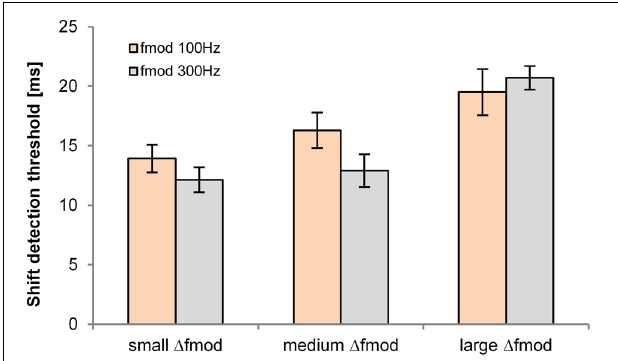
FIGURE 4 | Shift detection thresholds of the B SAM tone ( n = 6; mean and SEM) are shown for the (cid:2) f mod A of 100Hz (orange) and 300Hz (gray) for all (cid:2) f mod